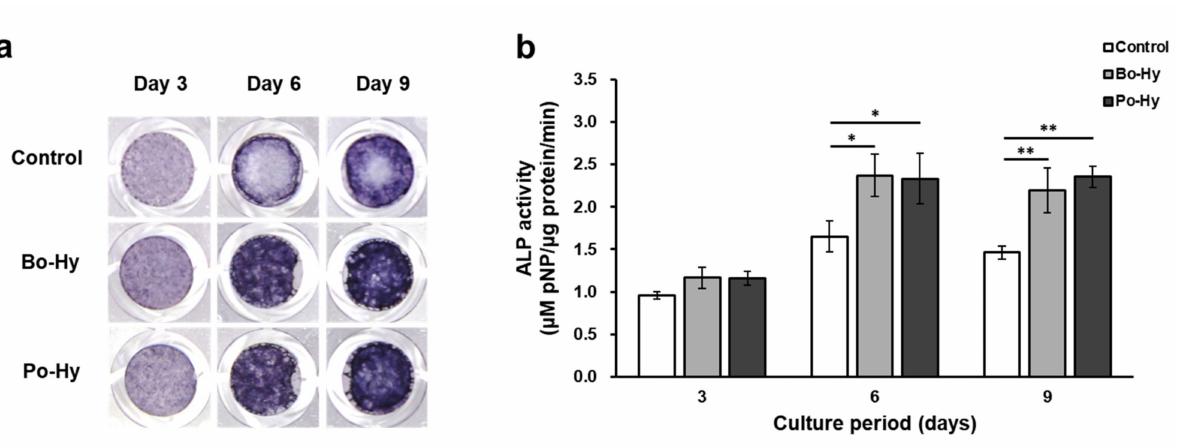
Figure 8. Cell osteogenic differentiation assay. ( a ) ALP staining and ( b ) ALP activity. Significant differences were observed when compared with the controls: * p < 0.05, ** p < 0.01, n =